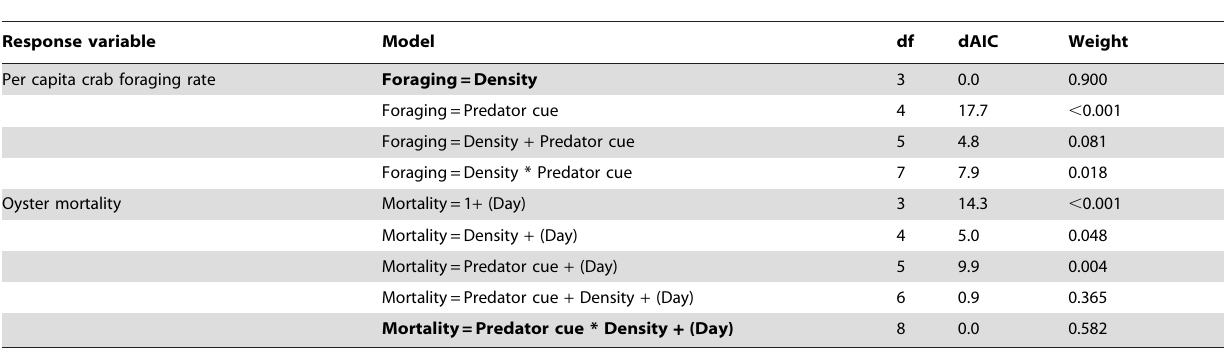
Table 2. Results of nested linear mixed-effect models for Experiment